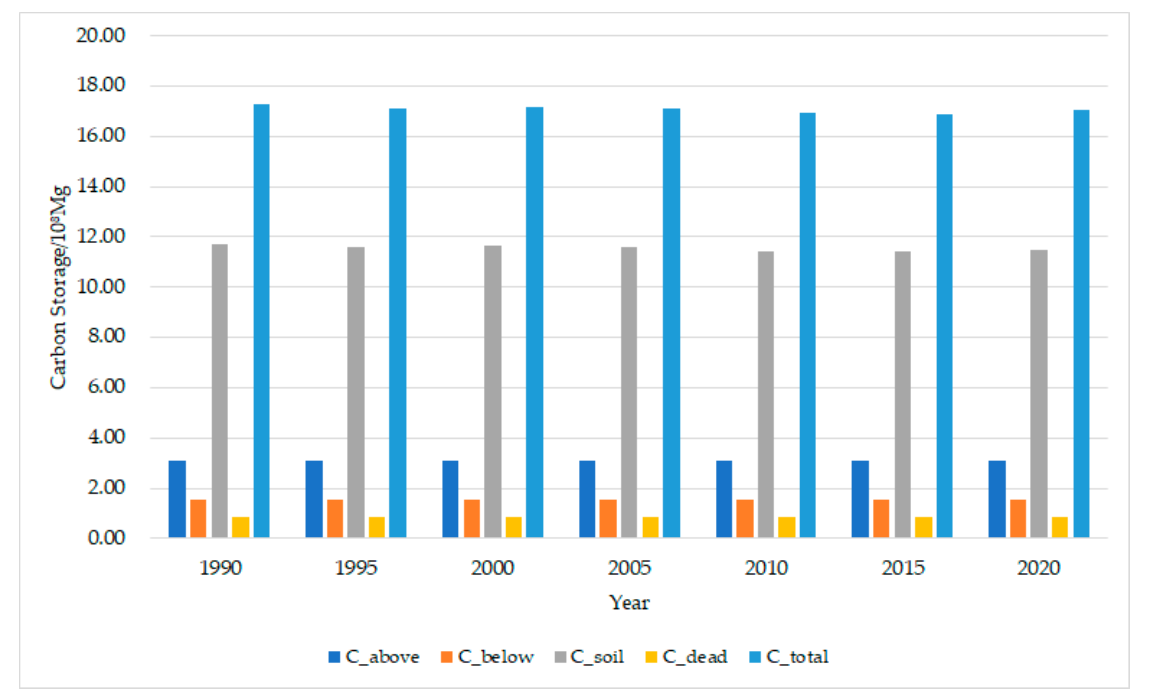
Figure 4. The changes in basic carbon storage from 1990 to 2020.